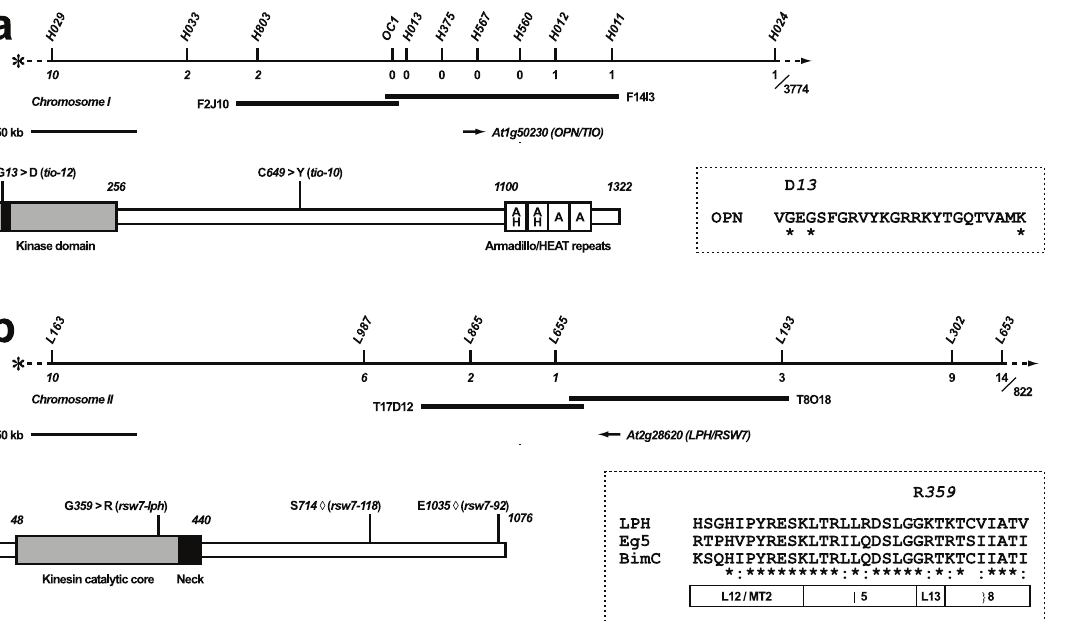
Fig 3. Molecular cloning of OPN/TIO and LPH/RSW7 . ( a ) Top: Genetic and physical map of the OPN/TIO region on the lower arm of chromosome 1. Numbers below the line indicate the number of recombination events between opn/tio mutations and the corresponding molecular markers (with italics referring to recombinants on the centromeric side, and the total number of meiotic events analyzed listed on the far right); two BAC clones (black bars) spanning the OPN / TIO transcription unit (arrow) are shown below the map. Bottom: Domain structure of the TIO protein. The N-terminus consists of a FU - type kinase domain (gray bar, with the ATP binding pocket in black); the C-terminus contains four repeat motifs, the first two of which share significant similarity with Armadillo and HEAT repeats (white boxes labeled “ AH ” ), while the second two show borderline similarity to Armadillo repeats ( “ A ” ; [35]); the tio - 12 allele (mutation 12 – 15 ) harbors a glycine to aspartic acid substitution in the ATP-binding pocket (listed in the dashed box, invariant positions of the consensus sequence marked with a star); the PROSITE consensus (motif no. P00107) of this sequence signature is: [LIV]-G-{P}-G-{P}-[FYWMGSTNH]- [SGA]-{PW}-[LIVCAT]-{PD}-x-[GSTACLIVMFY]-x(5,18)-[LIVMFYWCSTAR]-[AIVP]-[LIVMFAGCKR]-K; the tio-10 allele (mutation OX10 ) harbors a cystein to tyrosine substitution in a portion of OPN without significant similarity to known motifs. ( b ) Top: Genetic and physical map of the LPH/RSW7 region on the lower arm of chromosome 2, organized as in ( a ). Bottom: Domain structure of the predicted RSW7 protein. The N-terminal catalytic core (grey bar) and the neck domain (black bar) show strong similarity to members of the kinesin-5 family; the insertion sites of the two T-DNA alleles, rsw7-118 and rsw7-92 , are marked with diamonds; the rsw7 - lph allele harbors a glycine to arginine substitution in a conserved portion of the catalytic core; an alignment of this portion with human Eg5/KIF11 and E . nidulans BimC (GenBank accession nos. P52732, P17120) is shown in the dashed box, with stars representing invariant and colons conserved positions; folding of this domain is shown below the alignment and inferred from the crystal structure of rat brain kinesin [67] (L12/MT2: loop 12, microtubule binding domain 2; α 5: alpha helix 5, L13: loop 13, β 8: beta sheet 8).